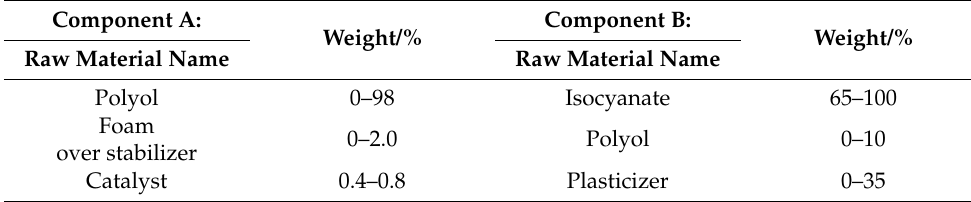
Table 1. Material composition table. Component